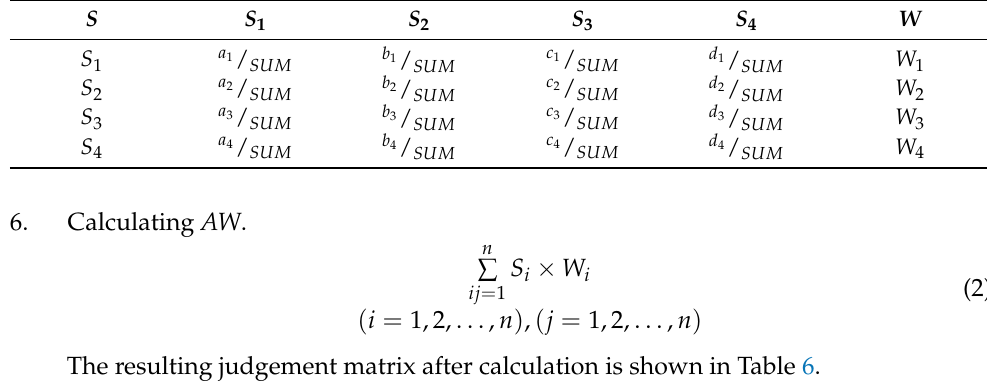
Table 6. Judgement matrix after calculation.